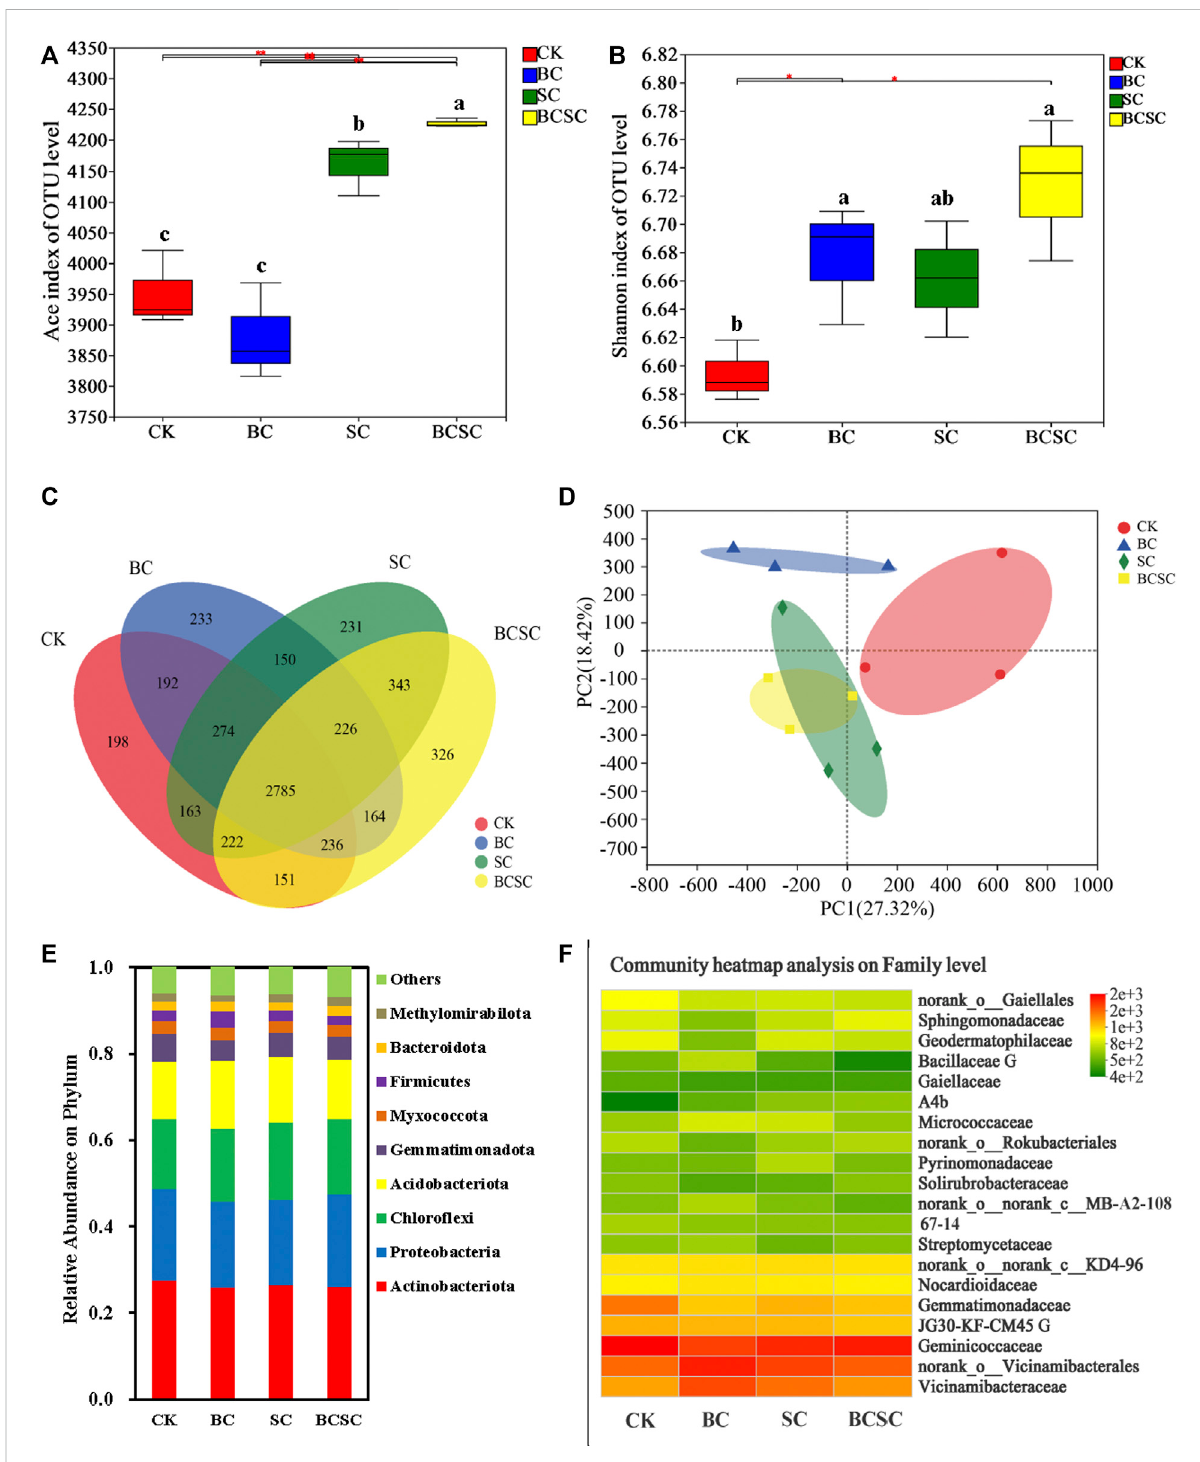
FIGURE 5 Effect of biochar, compost, and biochar-compost on the microbial community in coastal soils planted with sorghum. (A) Chao1 index; (B) Shannon index; (C) Venn diagram showing the shared bacterial OTUs; (D) principal component analysis (PCA) of bacterial community composition based on Bray – Curtis similarity; (E) the relative abundance of bacteria at the phylum level; and (F) heatmap of the top 15 bacteria at the family level using the Bray – Curtis distance and complete clustering method in the coastal soil with biochar amendment. CK: soil without amendment; BC: soil amended with corn straw biochar at 1.0% (w/w); SC: soil amended with seaweed compost at 1.0% (w/w); and BCSC: soil amended with cocomposted biochar and seaweed at 1.0%